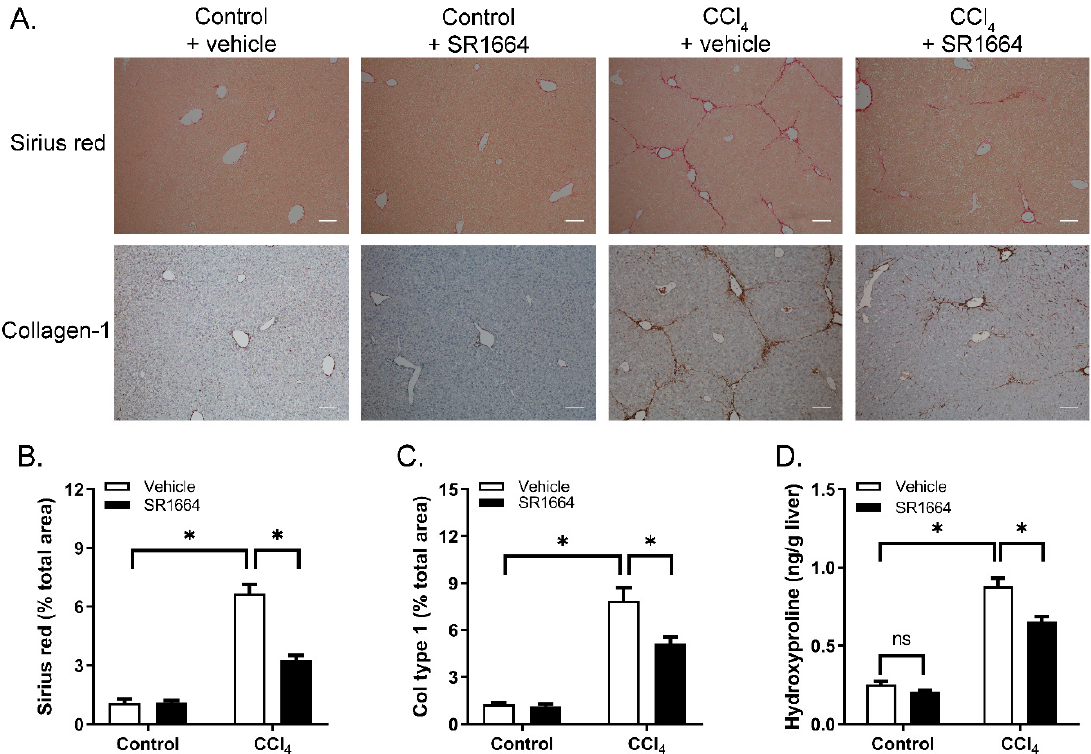
Figure 2. Collagen deposition in liver from control or fibrotic mice treated with SR1664 or vehicle. ( A ) Sirius red stain of total collagen (top panel) or immunohistochemistry for type 1 collagen (bottom panel); bar = 200 µ m. ( B ) Quantification of Sirius red staining intensity.( C ) Quantification of type 1 collagen staining. ( D ) Liver tissue hydroxyproline content. Mean ± S.E.M.; n = 6; * p < 0.05 by ANOVA; ns: not significant.